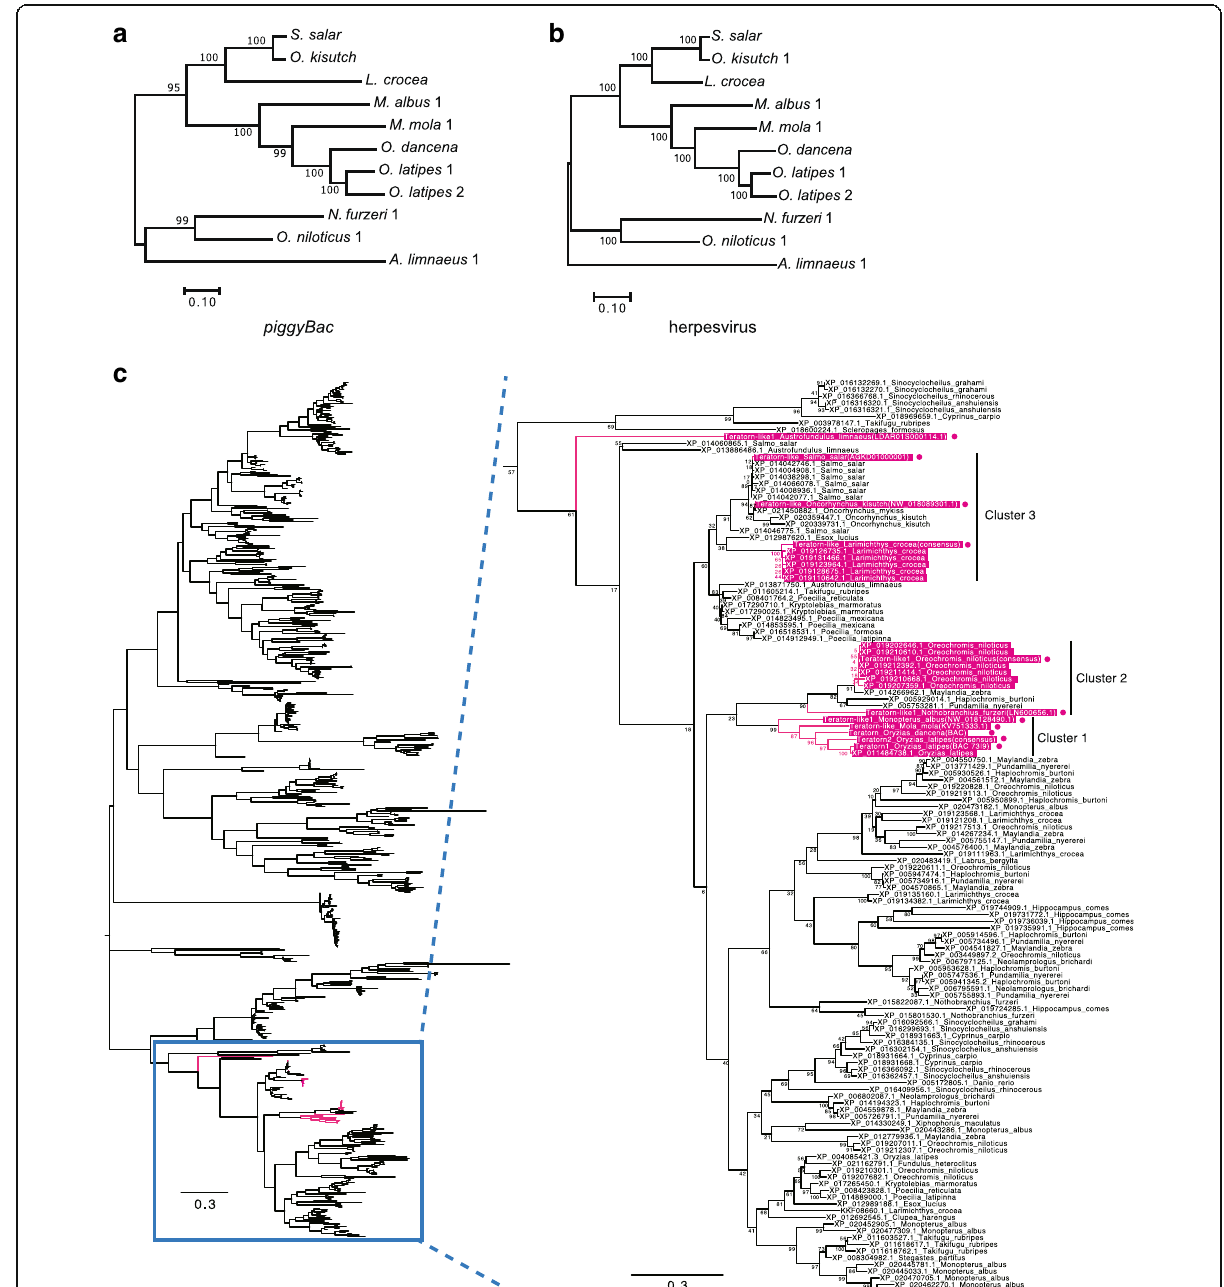
Fig. 4 Phylogenetic comparison between piggyBac -like elements and herpesvirus-like genes ( a ) A Maximum-likelihood tree based on the nucleotide sequences of piggyBac -like transposase genes inside Teratorn -like viruses is shown. General time reversible model was used as the substitution model, and evolutionary rate differences among sites was modeled by discrete gamma distribution. A total of 1518 positions were used in the final dataset. b A maximum-likelihood tree based on the concatenated nucleotide sequences of five herpesvirus genes (DNA polymerase, DNA helicase, terminase, major capsid protein, membrane glycoprotein) is shown. General time reversible model was used as the substitution model, and evolutionary rate dif- ferences among sites was modeled by discrete gamma distribution. A total of 13,683 positions were used in the final dataset. c A maximum-likelihood tree based on the amino acid sequences of all annotated piggyBac -like transposase genes in teleosts is shown. Expansion of the clade surrounded by the blue square is shown on the right. Magenta indicates piggyBac -like transposase genes inside Teratorn -like viruses. JTT model was used as substitu- tion model, and evolutionary rate differences among sites were not modeled. The bar represents the number of substitutions pre site. A total of 324 positions were used in the final dataset. Note the existence of three clusters containing piggyBac -like elements fused with Teratorn -like viruses, the phyl- ogeny of which is highly correlated with that of Teratorn -like viruses (see Fig. 1b). Sequences used for the phylogenetic tree in (a) are marked by ma- genta circles. The scale bars represent the number of substitutions per